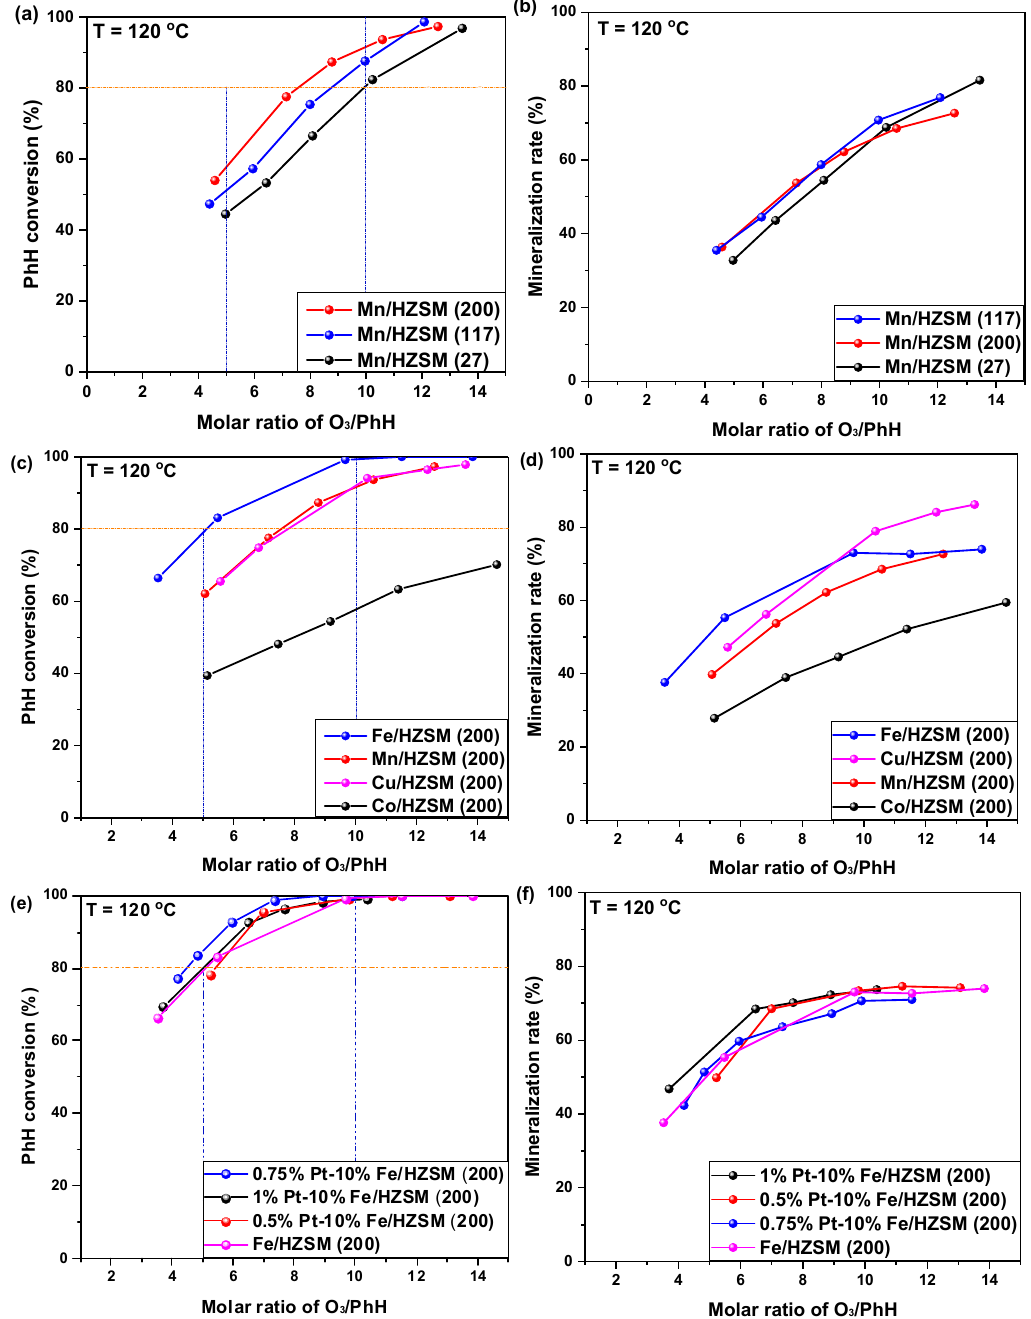
Figure 1. Catalytic ozonation of PhH (C 6 H 6 ) over HZSM-supported catalysts. Initial PhH concentration: 100 ppm, O 2 concentration: 10%, catalyst dosage: 25 mg, reaction temperature: 120 °C, GHSV: 40,000 h − 1 . ( a , b ) Catalytic behavior over HZSM supported Mn catalysts with different SiO 2 /Al 2 O 3 ratios; ( c , d ) Catalytic behavior over HZSM (200) supported catalysts with different metals; ( e , f ) Catalytic behavior over HZSM (200) supported Fe catalysts with Pt doping.